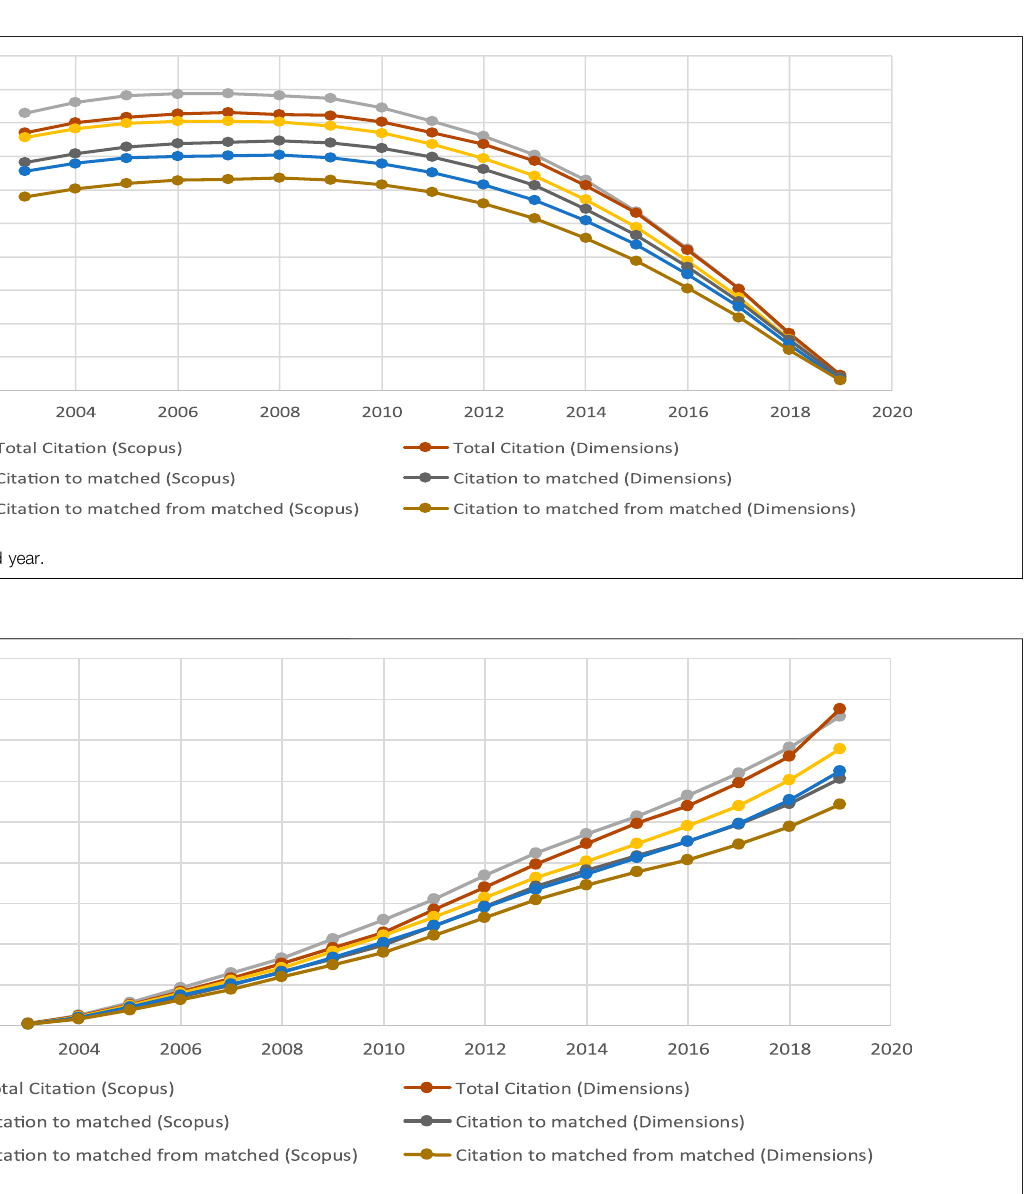
FIGURE 7 | Citations by citing